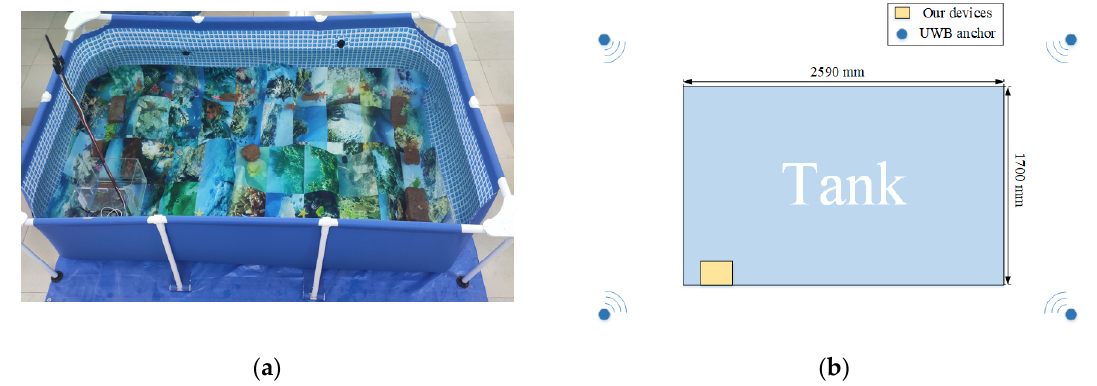
Figure 7. ( a ) The experiment environment; ( b ) The layout of experiment environment.